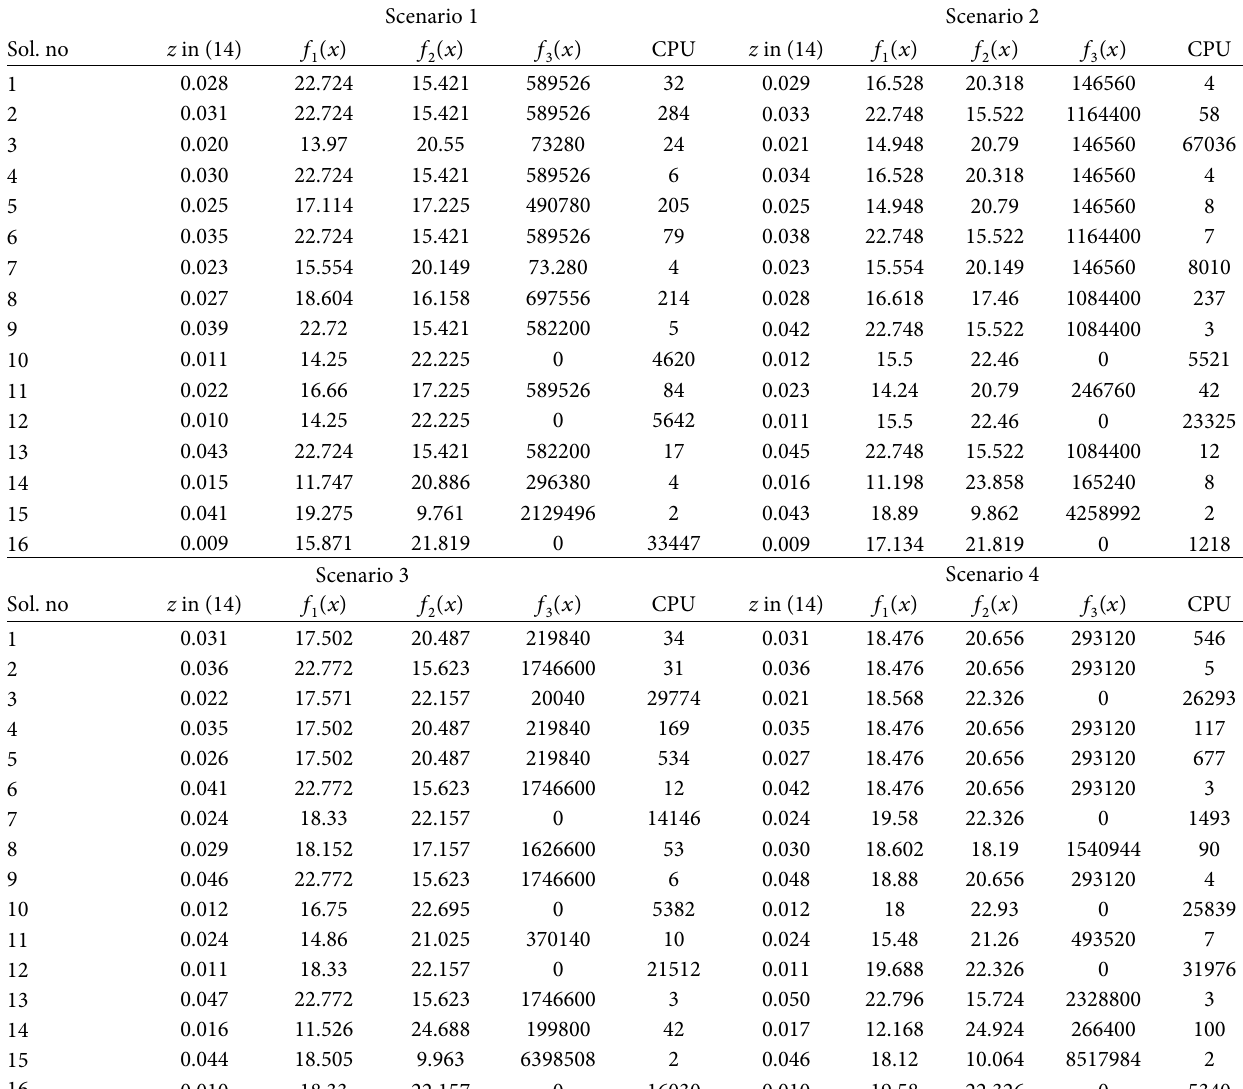
Table 7: 16 representative efficient solutions from the Pareto frontier for each event